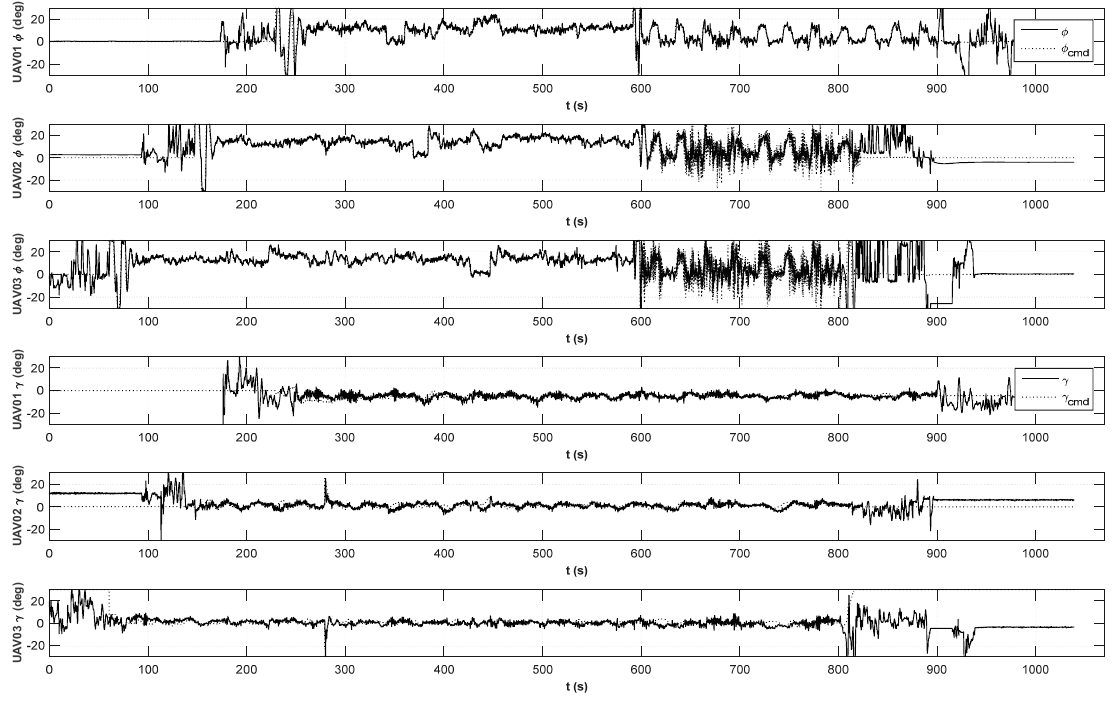
Figure 17. Lateral and longitudinal command histories of integrated formation flight.